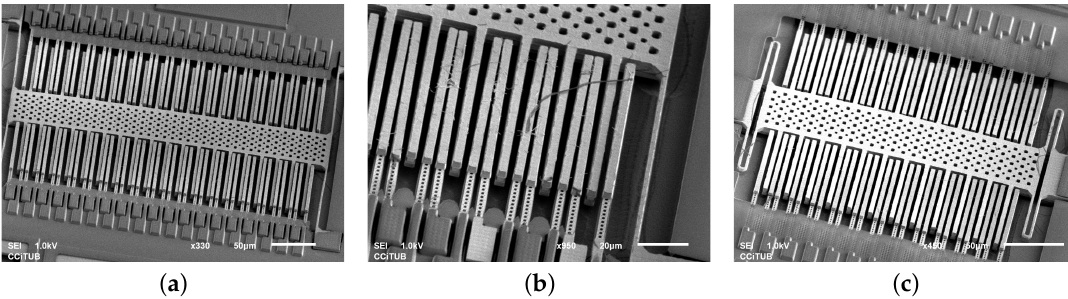
Figure 16. Lateral devices on Bailed chip: Buckling of TM2 fixed-fixed suspension in device T3 ( a )—yet more evidence of compressive stress in TM2 layer. Short-circuit due to lateral stiction and peeling of Ti/TiN ( b ) were the main failure mechanisms of stator comb. The passivation over TVia2 and TM2 was damaged as well. Device T1 ( c ) was the first successfully measured (see Figure 17) lateral device.